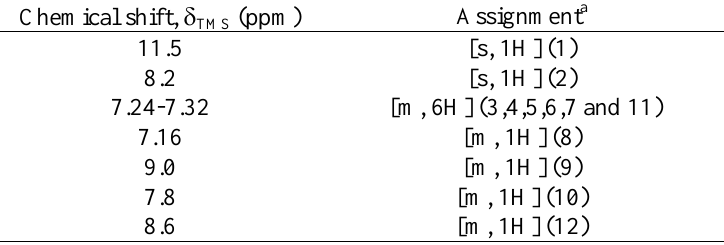
Table 2. 1 H-NMR data of the ligand HL in DMSO-d